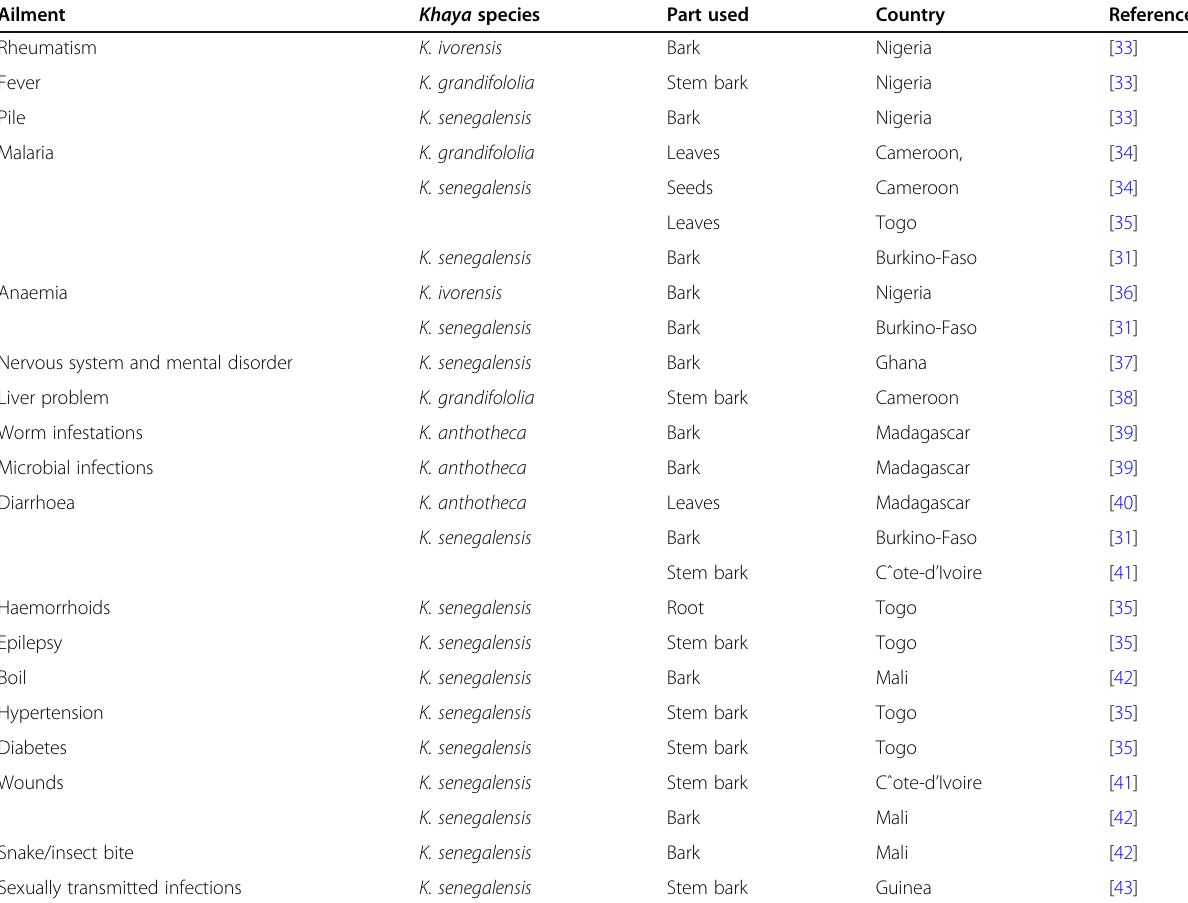
Table 1 Uses of Khaya species in traditional medicine